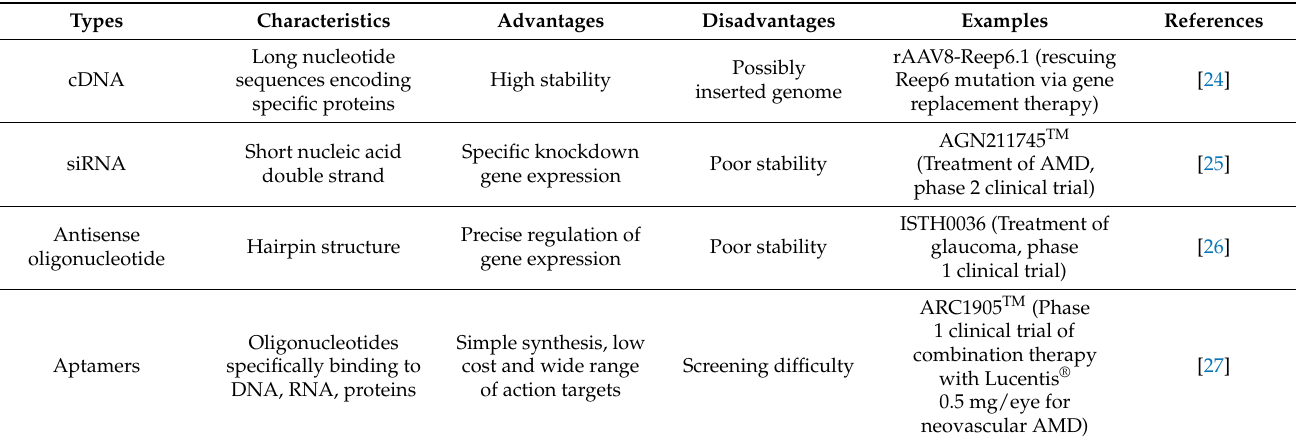
Figure 1. Classification of NADs. NADs include cDNA (translation function protein) [16], mRNA (translation function protein) [17] and noncoding RNAs [18]. Noncoding RNAs include ASO (antisense oligonucleic acid, binding target genes to regulate gene expression) [19], ribozymes (specific splicing RNA) [20], siRNA (RNA-induced silencing complexes (RISCs) degrade RNA) [21], miRNA (RISCs degrade RNA) [22], aptamers (specific binding to target molecules regulates gene expression) [23]. Table 1. Four different types of common NADs in